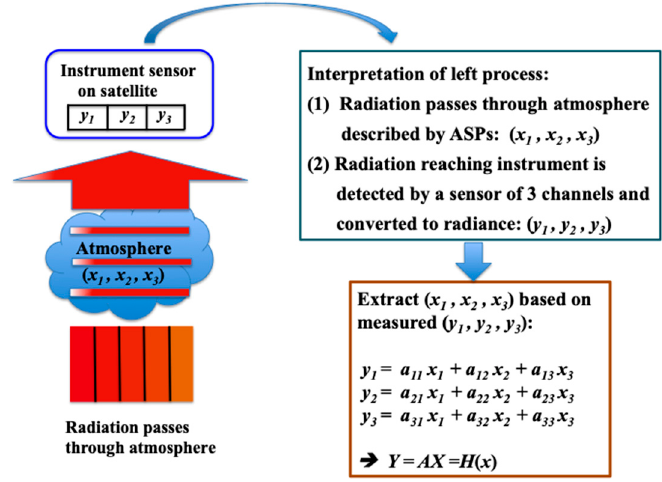
Figure 4. Simple toy examples employed to demonstrate the performance of the data-derived R